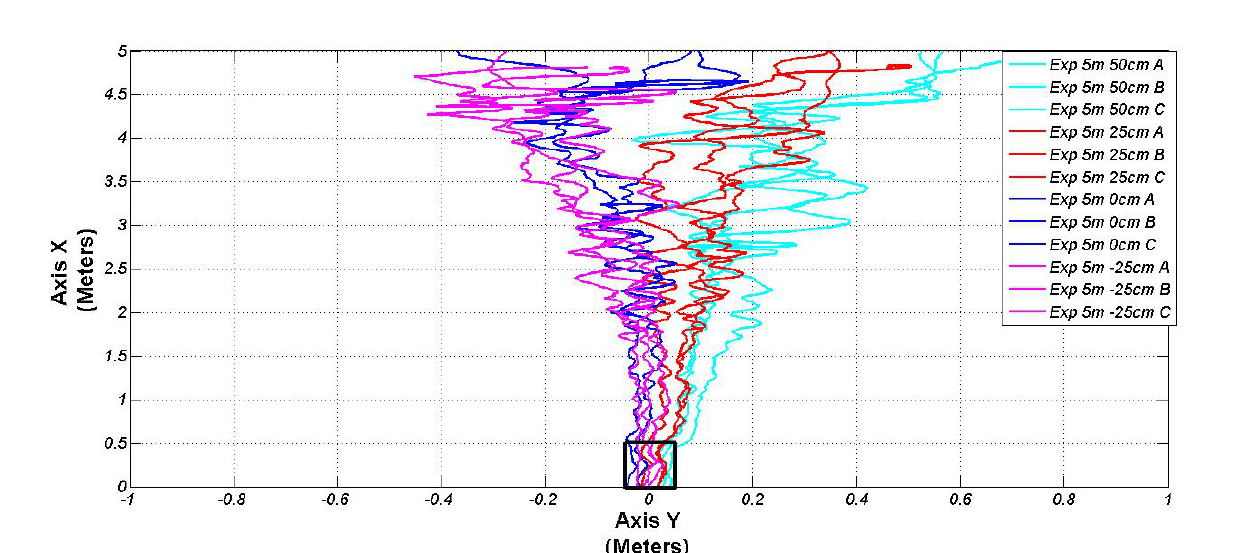
Figure 9. Validation tests: